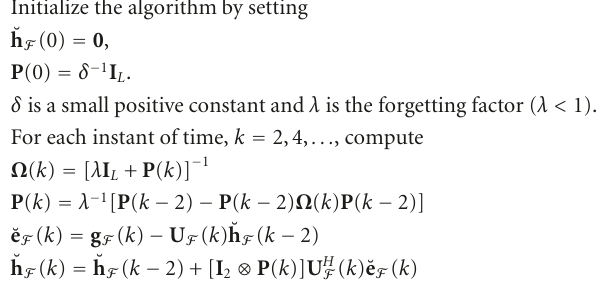
Table 4: Simplified block RLS